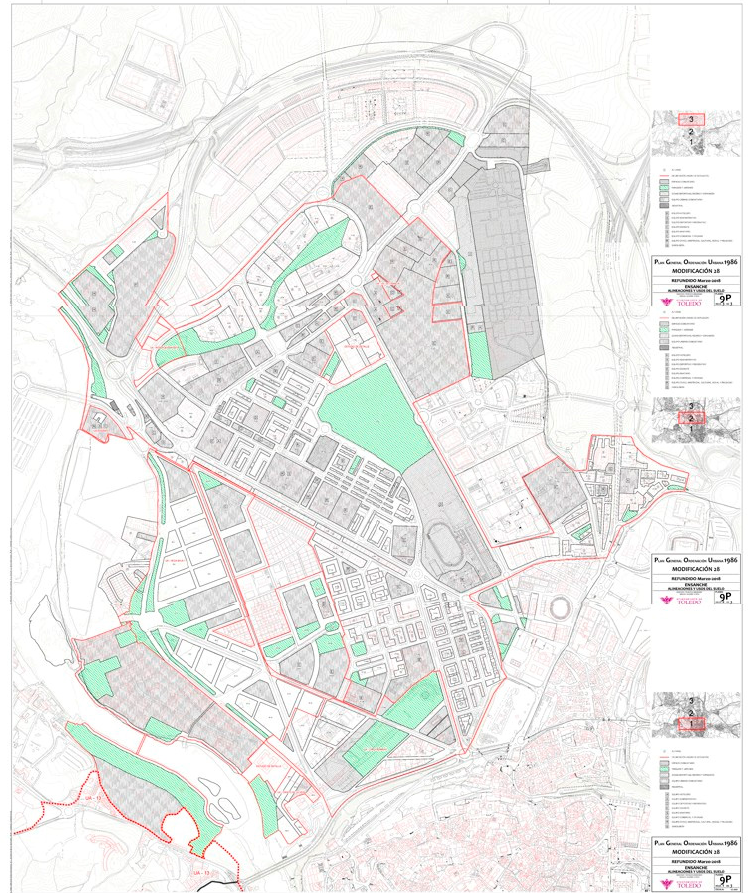
Figure 4. The Ensanche of Toledo in the 1986 PGOU. Source: City Council of Toledo [67] and self- elaboration.